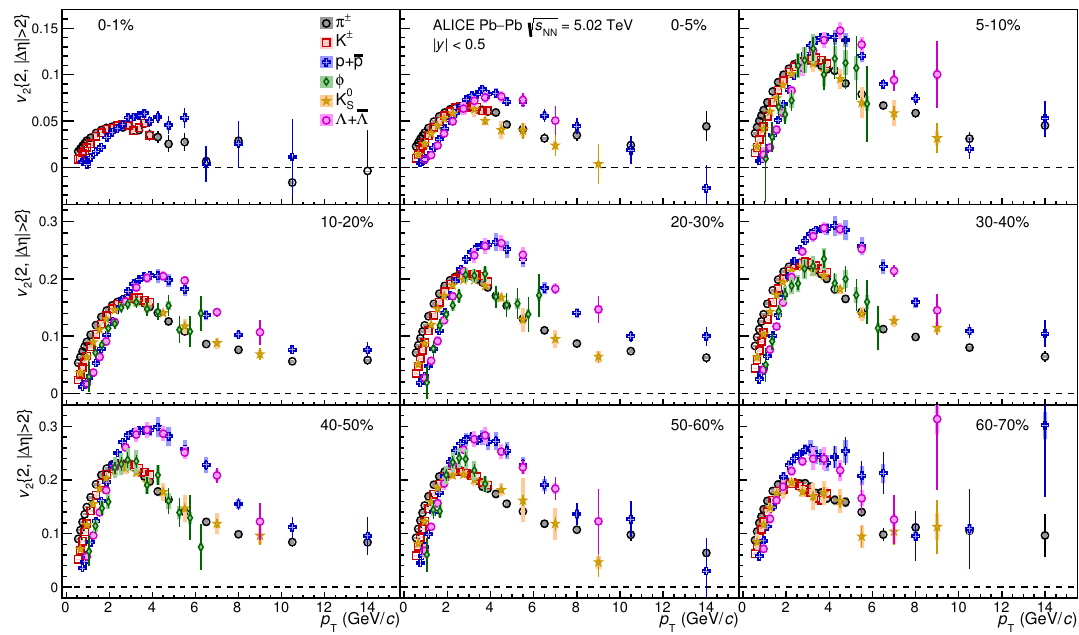
Figure 6 . (Colour online) The p T -di(cid:11)erential v 2 of (cid:25) (cid:6) , K (cid:6) , p+p, (cid:3)+(cid:3), K 0 various centrality classes. Statistical and systematic uncertainties are shown as bars and boxes,